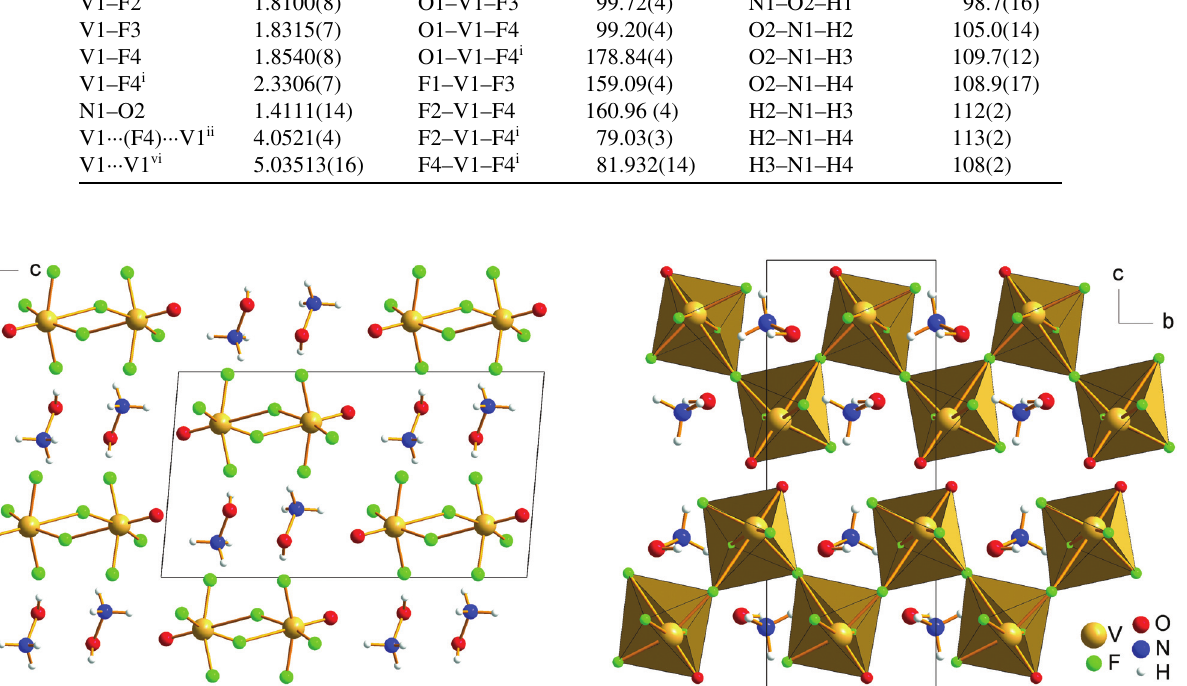
Figure 2. Packing in the unit cell of (NH anion depicted in [ 010 ] direction to the dimeric and centrosymmetric edge-sharing [ V between the crystal structures of (NH